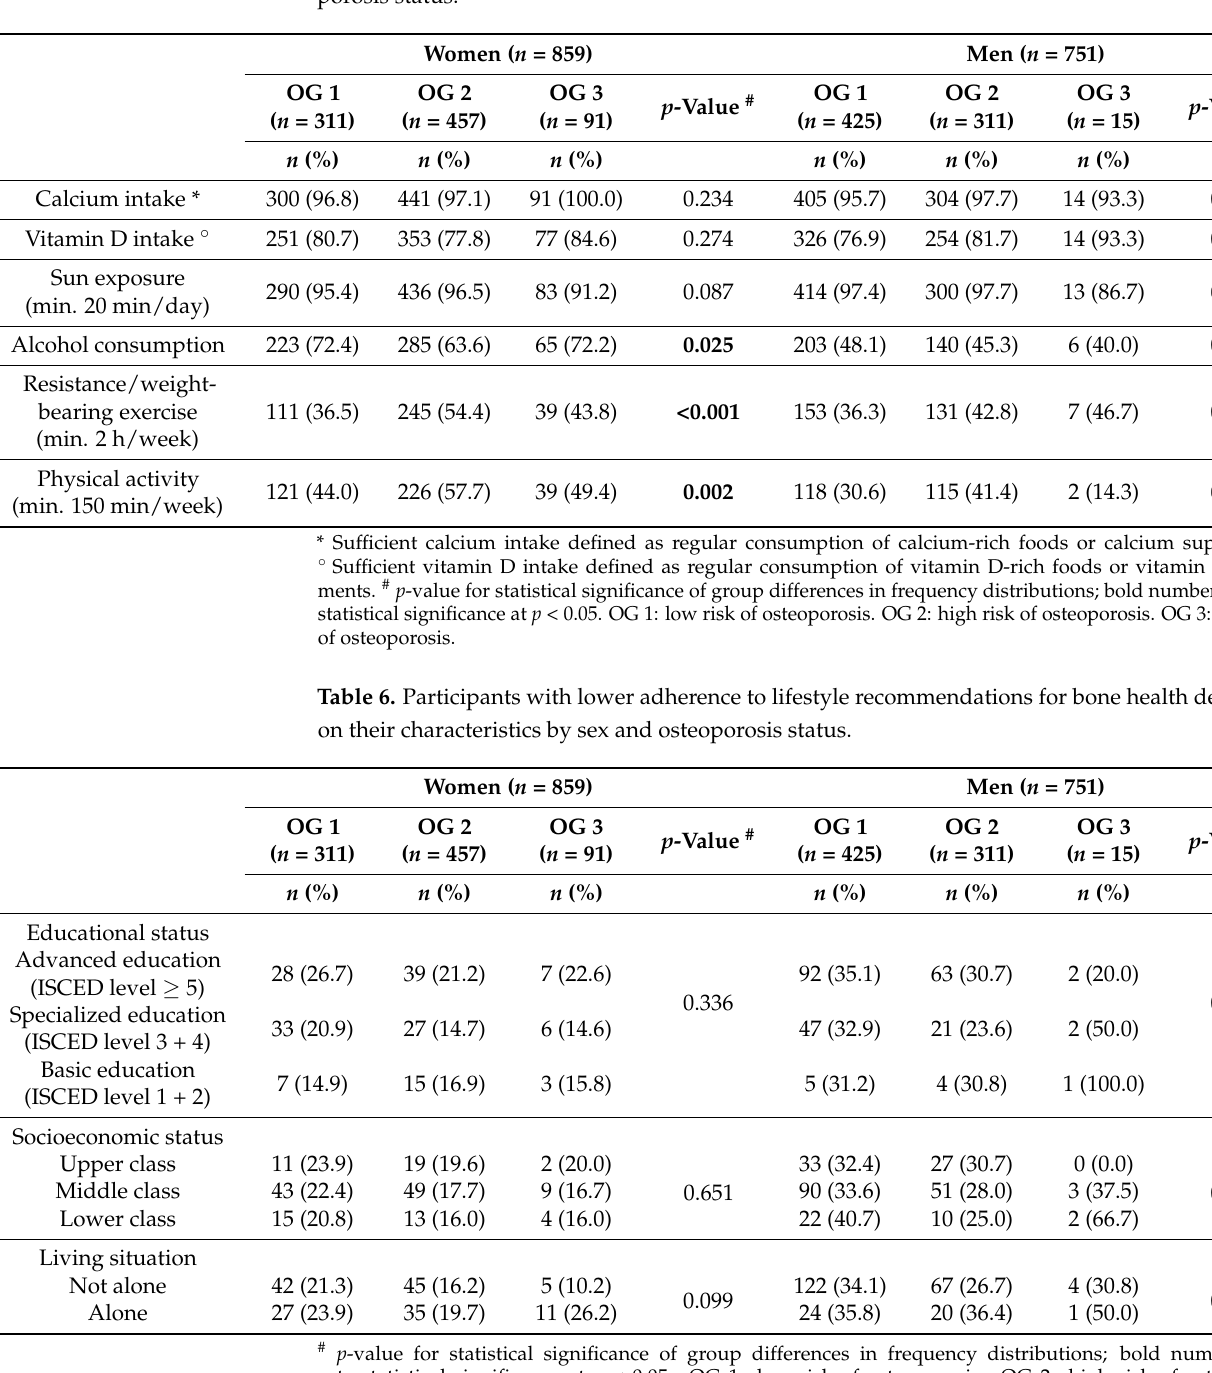
Table 5. Adherence to lifestyle recommendations for bone health of participants by sex and osteo- porosis status.